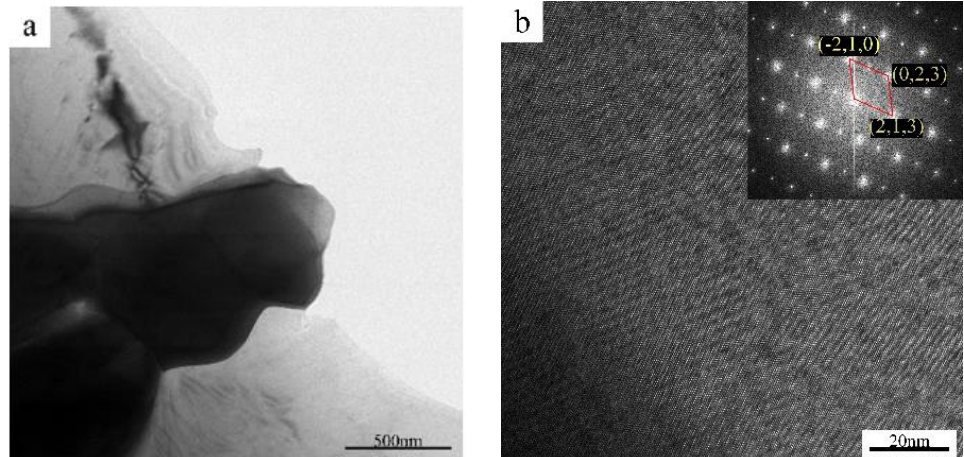
Figure 5. TEM micrograph of ZCVI alloy ( a ) Bright field TEM image, ( b ) High-resolution image and its FTT patterns.